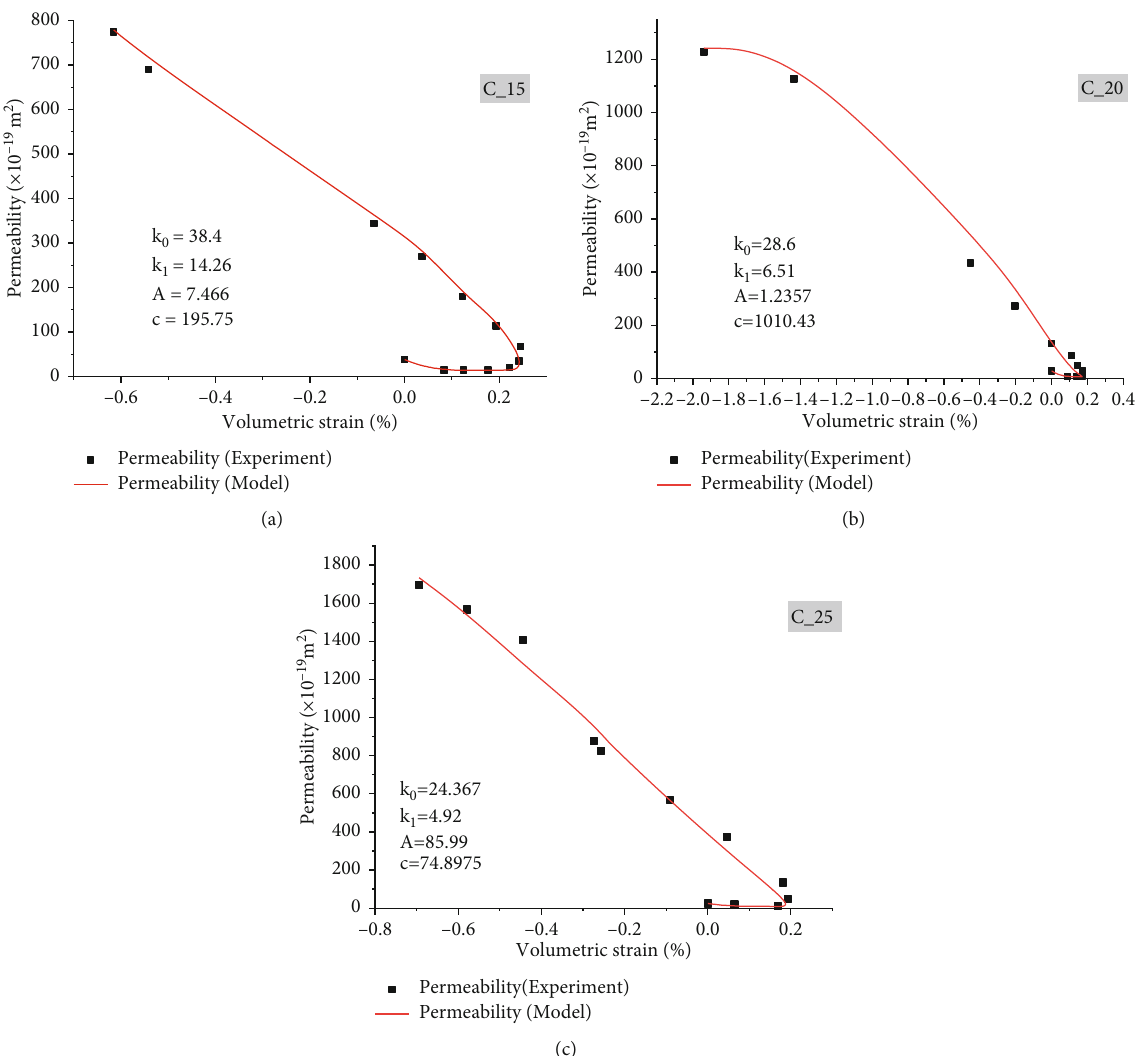
Figure 5: Experiment data and calculated results of permeability evolution of the specimen (a) C